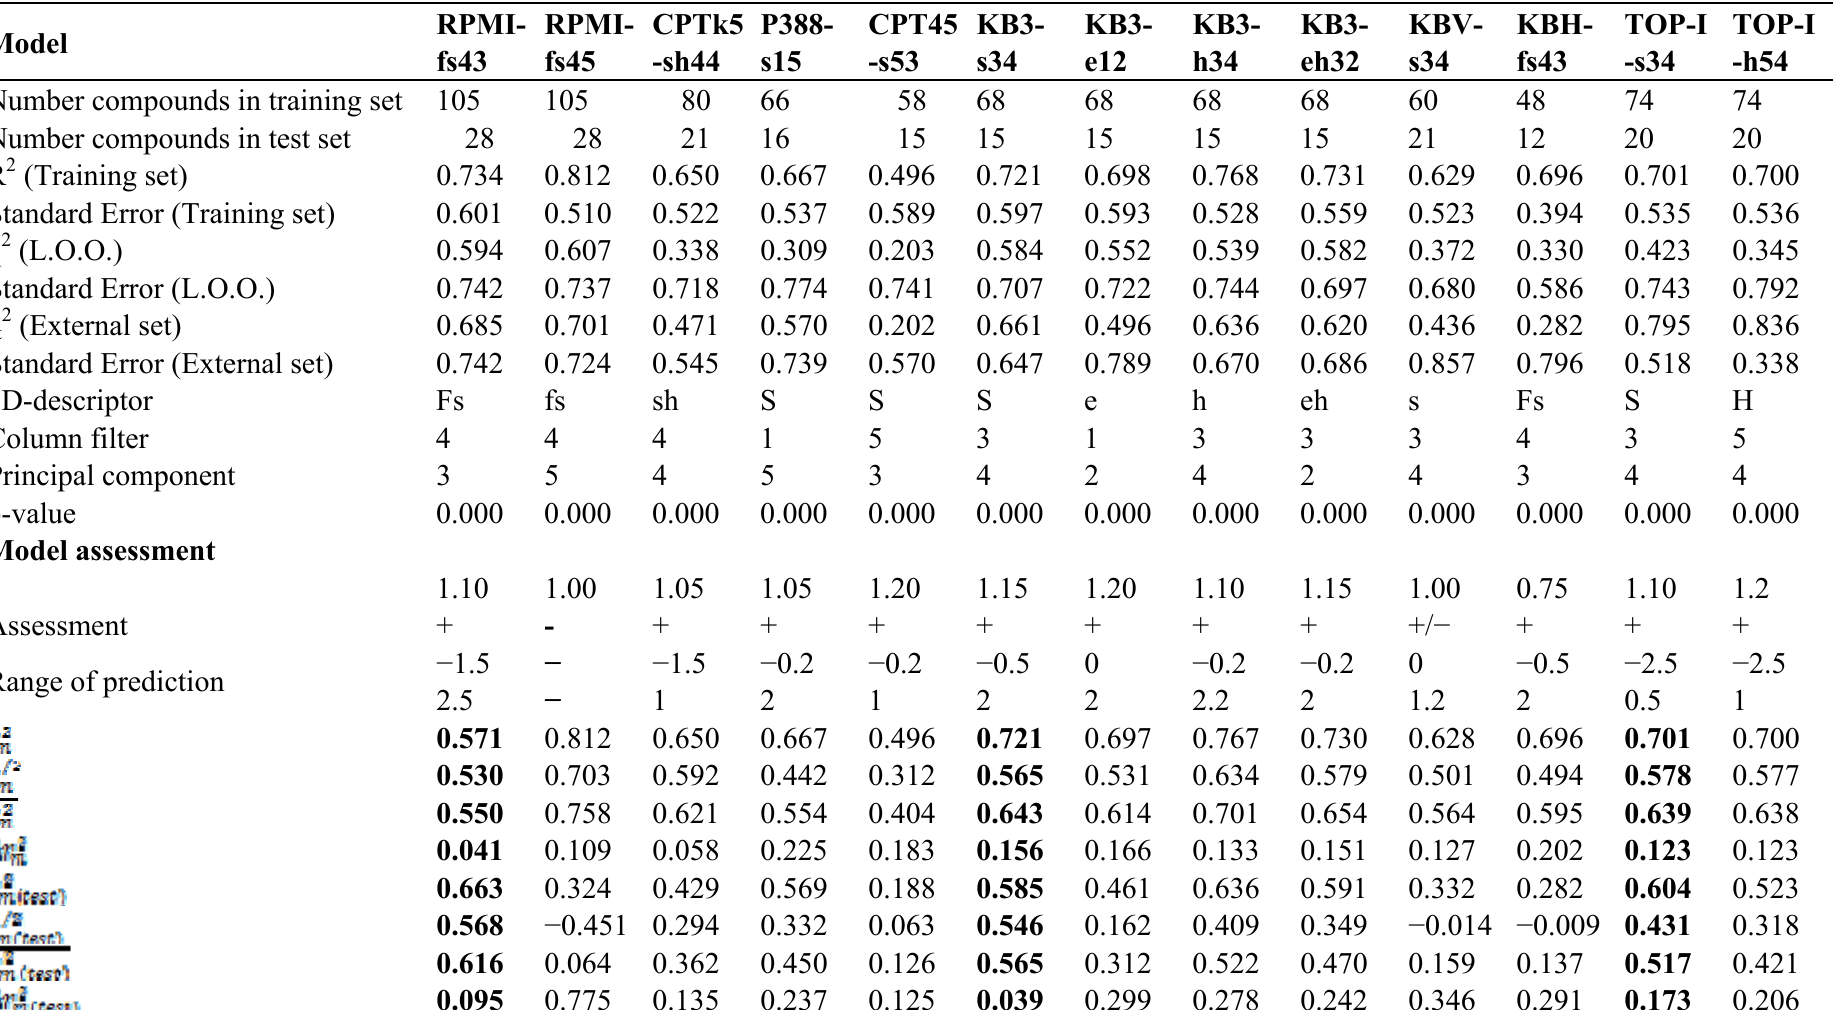
Table 5. Results of